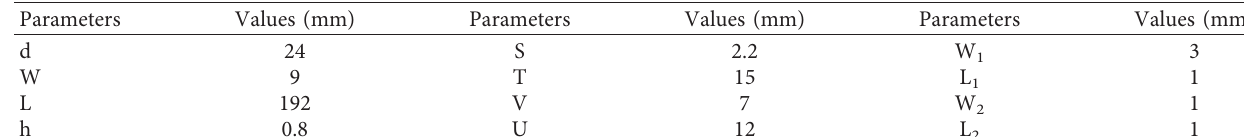
Table 1: Dimensions of the proposed periodic MLWA.